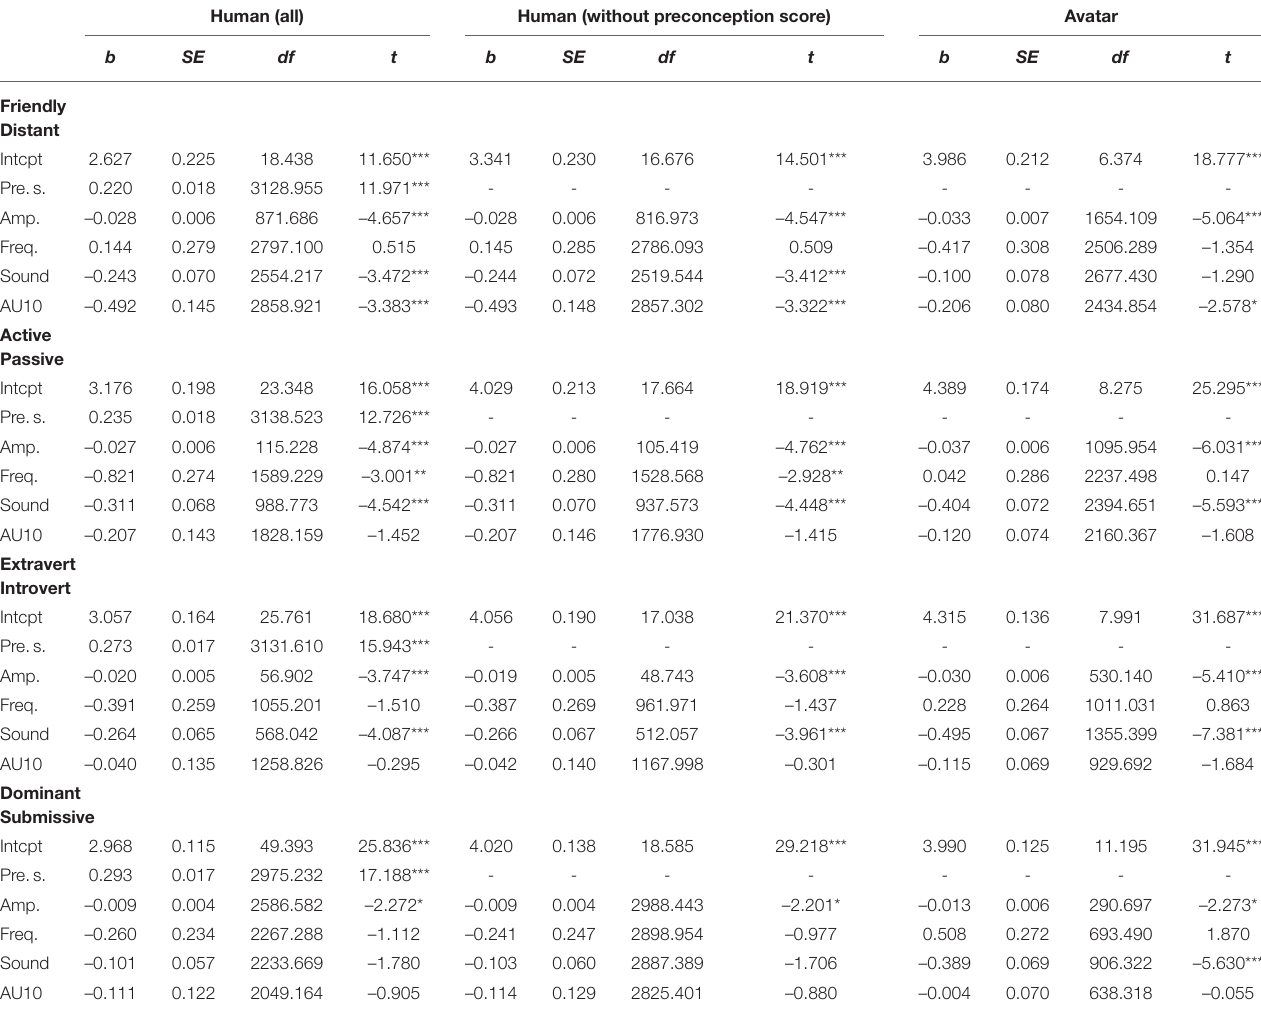
TABLE 2 | Overview of fixed effects for all 12